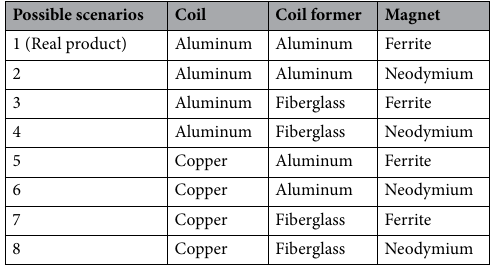
Table 1. Components of the models of loudspeakers motors.